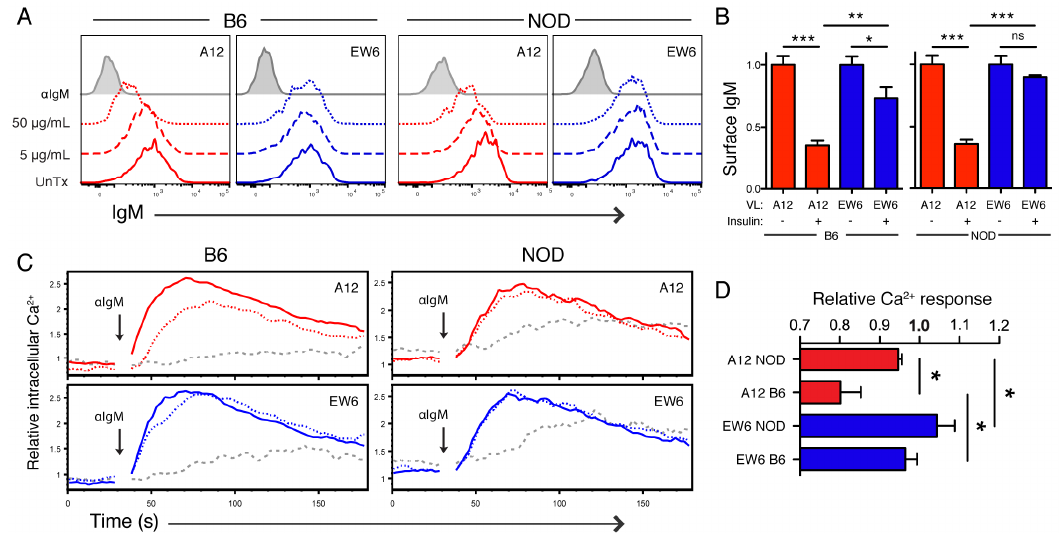
Figure 4. BCR affinity for insulin affects susceptibility to in vitro tolerance induction. ( A ) Surface IgM expression of high- and low-affinity TR-B cells from B6 or NOD background, gated on B220+ GFP+, 48 h post-treatment; ( B ) relative levels of B6 and NOD high-affinity TR-B surface IgM 48 h post-treatment with 50 µ g/mL human insulin, normalized to untreated control; ( C ) comparison of calcium responses to stimulation with 5 µ g/mL anti-IgM following culture with 50 µ g/mL human insulin (dotted), anti-IgM (gray dashed), or untreated (solid) for 48 h; ( D ) relative Ca 2+ response of TR-B cells as in ( C ), displayed as mean of area under the curve and peak height, normalized to untreated controls. Shown here are combined or representative results from more than three experiments, error bars denote SEM of replicates, Student t -test used (* p ≤ 0.05, ** p ≤ 0.01, *** p ≤ 0.001).